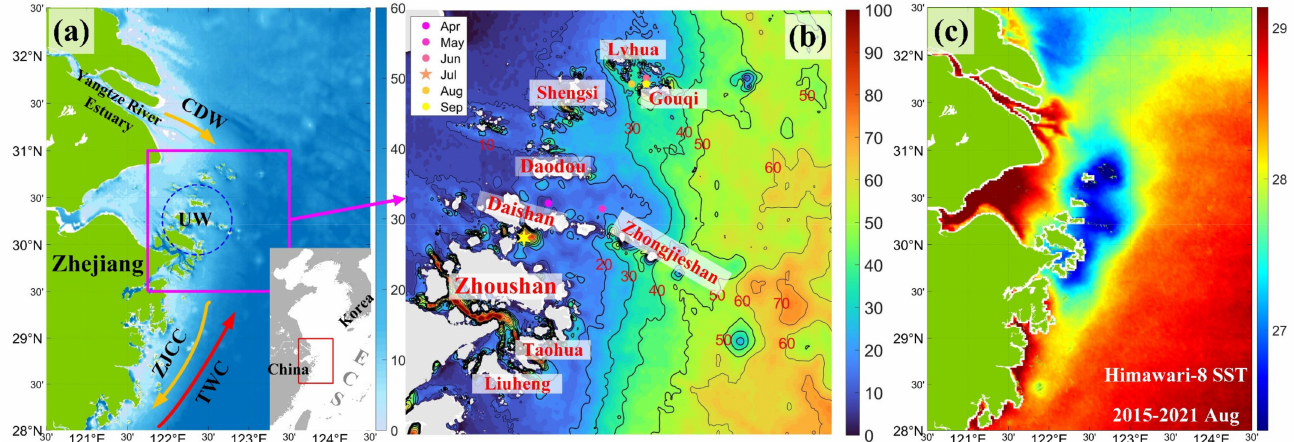
Figure 1. ( a ) Bathymetry and circulation patterns (meters) of the East China Sea; ( b ) the bathymetry (meters) of study area; ( c ) monthly mean SST ( ◦ C) in August 2015 − 2021 from the Himawari − 8 data. The dots and five − pointed star in panel ( b ) show monthly locations of the upwelling center between July 2015 and December 2021. The yellow six − pointed star in panel ( b ) shows the location of the tide station used in Section 3.3. The black lines in panel ( b ) are the isobaths between 10 m and 70 m. CDW : Changjiang diluted water; ZJCC : Zhejiang coastal current; TWC : Taiwan Warm Current; UW :